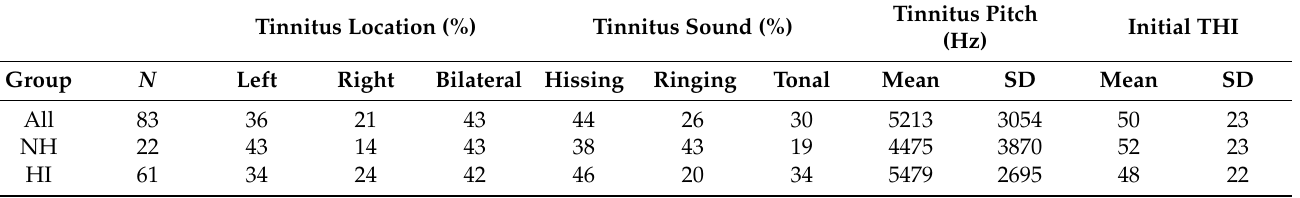
Table 3. Tinnitus features of patients by subgroups.